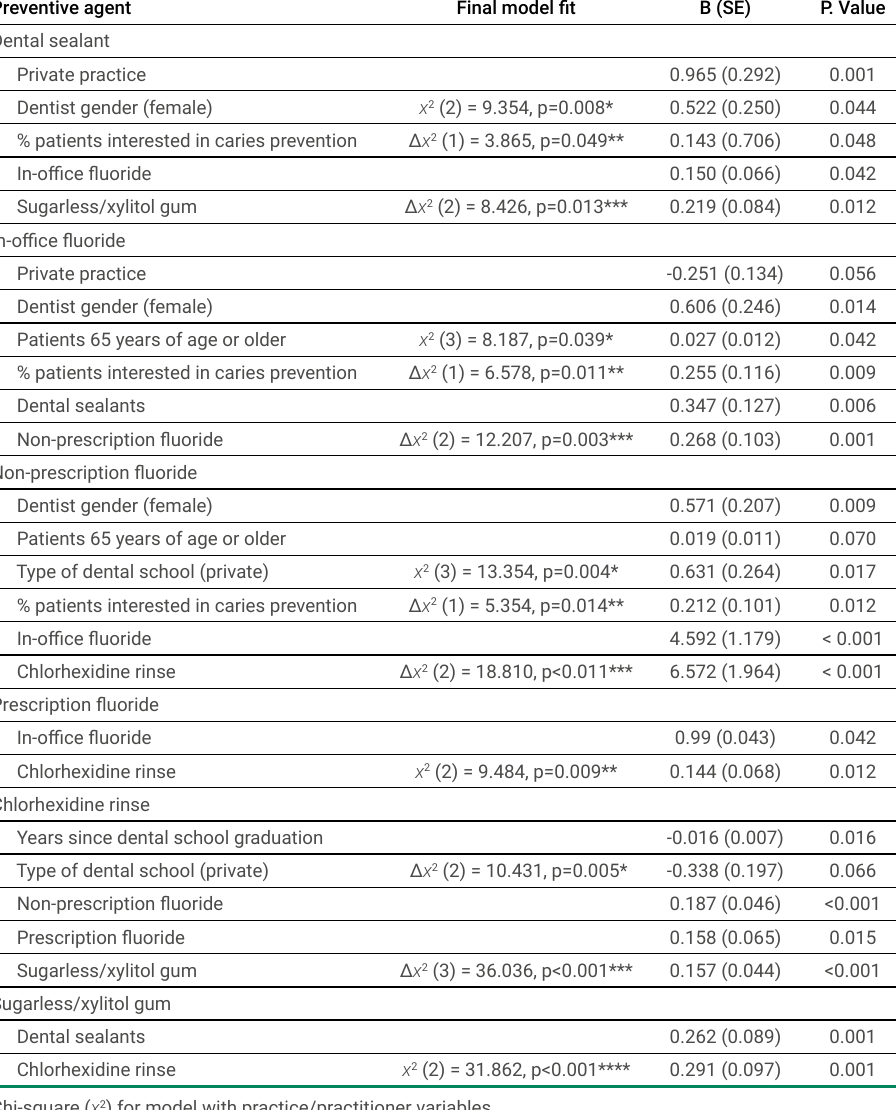
Table 4. Modeling to explain the use of preventive agents among adult patients Preventive